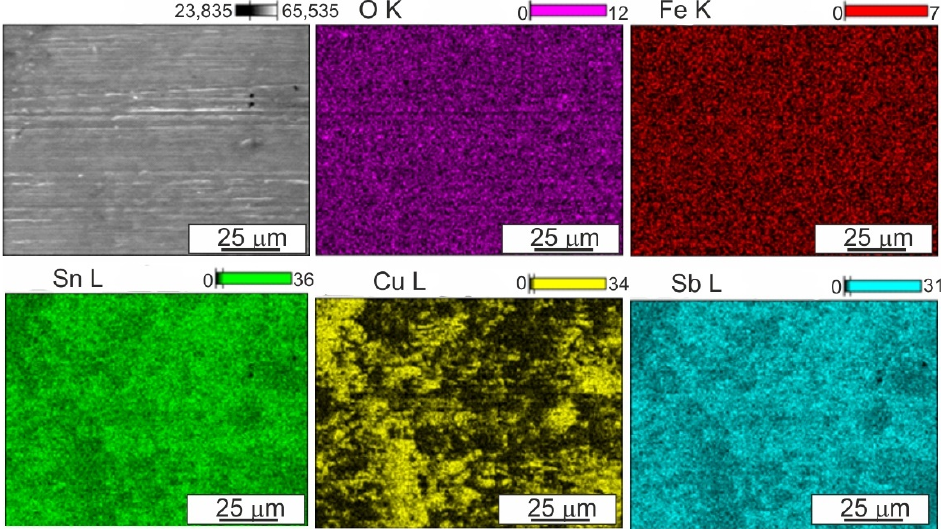
Figure 15. Surface after friction of B89 alloy in initial state and maps of distribution of elements: O, Fe, Sn, Cu, Sb; lubricated friction; SEM